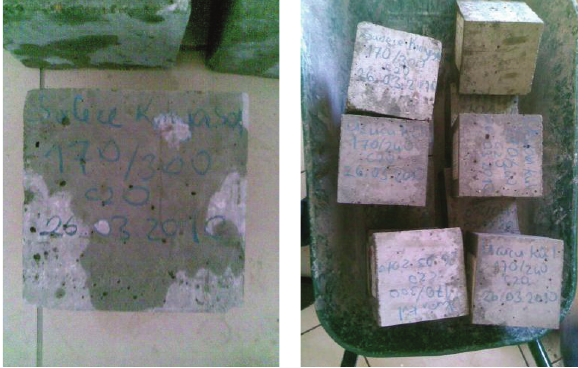
Figure 4: The comparison of compressive strength of specimens cured in sodium sulfate solution with respect to time